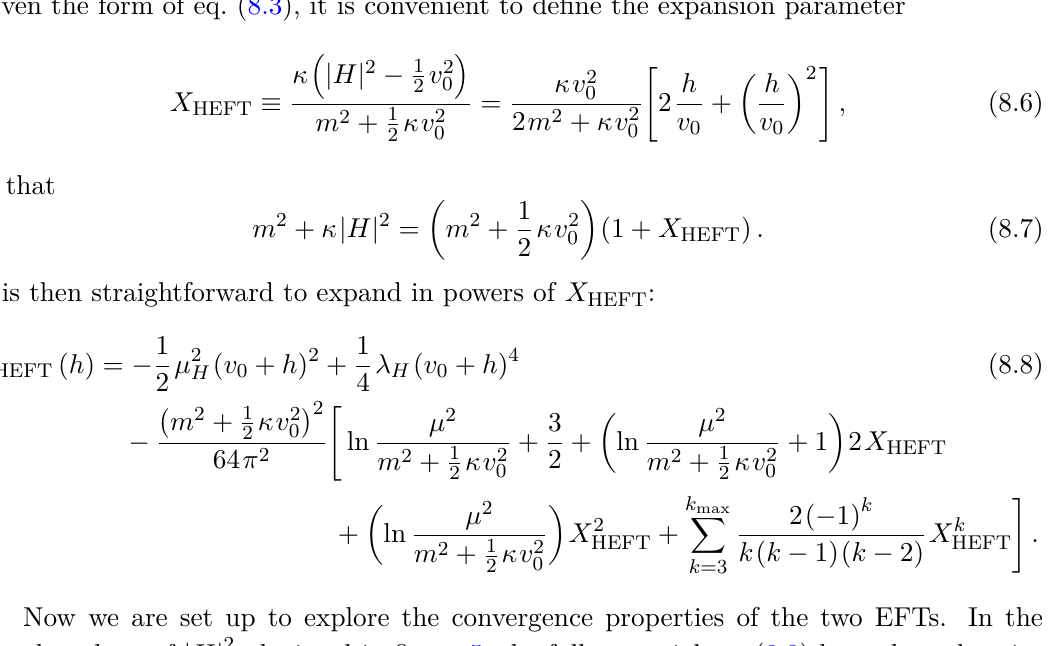
/ 2) . The full potential has a branch point at 0